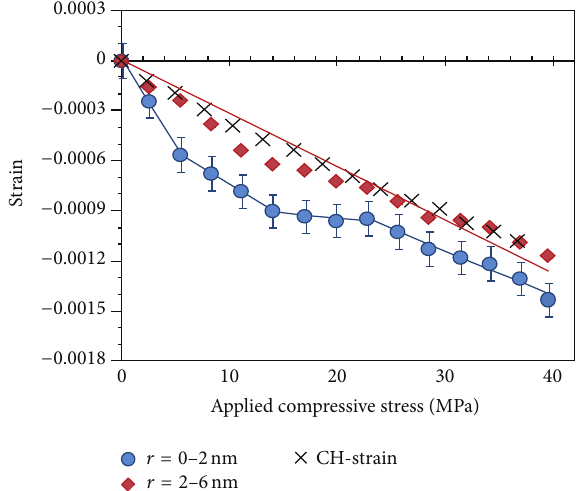
Figure 4: Change in the atomic strains that averaged in the ranges from 0 nm to 2.0nm in 𝑟 and from 2.0 nm to 6.0 nm in 𝑟 , compared with a change in the strain of the CH phase derived from the Bragg peak shift. The average error bars are ±1.0 × 10 −4 and ±1.5 × 10 −5 ,